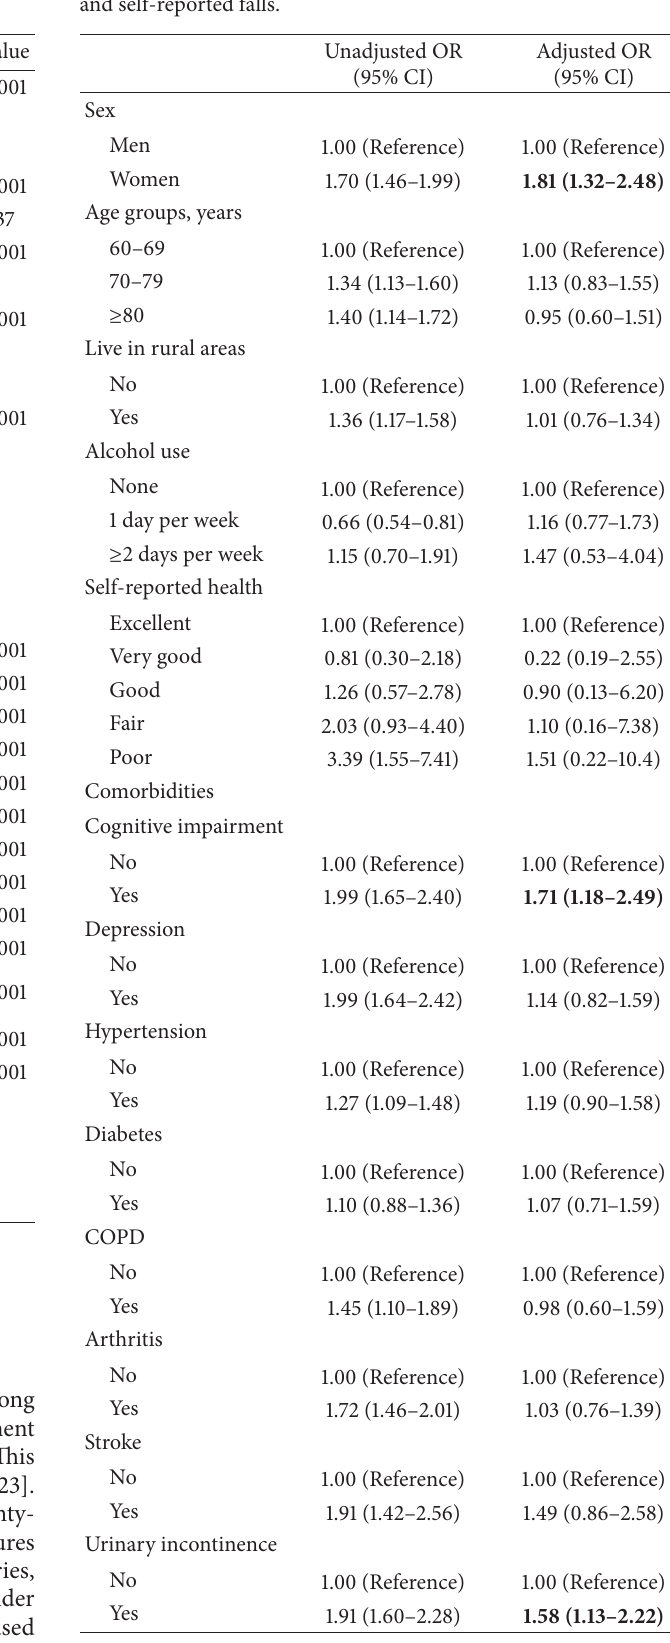
Table 2: Associations between characteristics of the participants and self-reported